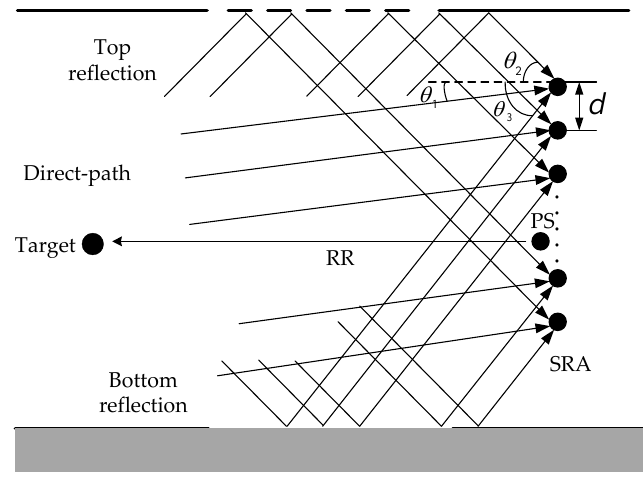
Figure 3. Multipath DOA estimation diagram for ULA.